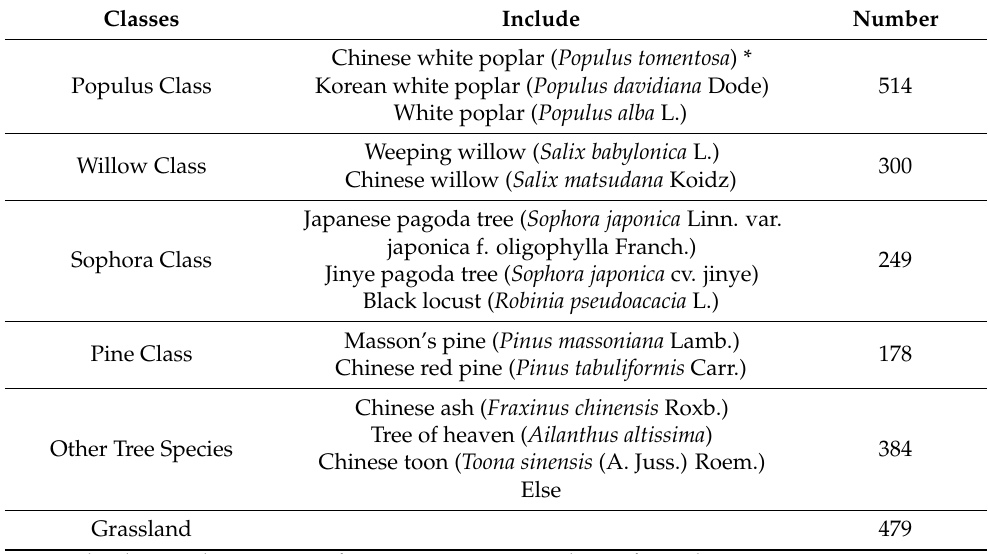
Table 1. The number of sample points in each class.